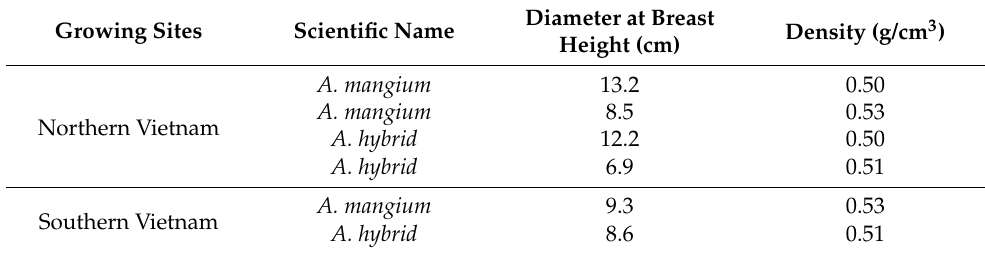
Table 1. Fundamental information of Acacia mangium and Acacia hybrid wood